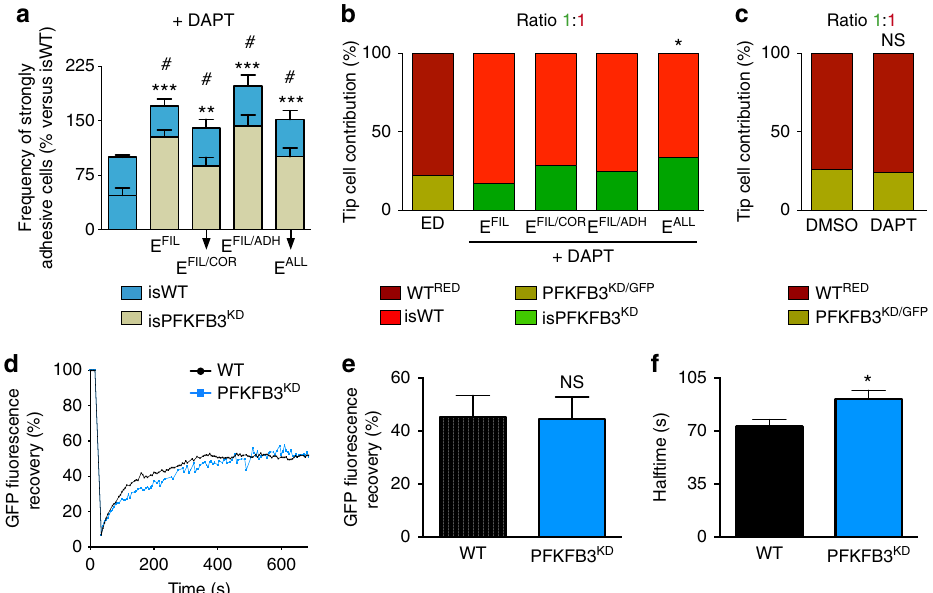
Figure 4 | PFKFB3 KD increases intercellular heterogeneity. ( a ) Analysis of EC adhesive strength of isWT cells in isWT:isWT sprouts (first bar) and isPFKFB3 KD-FIL , isPFKFB3 KD-FIL/COR , isPFKFB3 KD-FIL/ADH and isPFKFB3 KD-ALL cells in a 1:1 isPFKFB3 KD :isWT mosaic sprout treated with DAPT. Modifying E FIL , E FIL/COR , E FIL/ADH and E ALL increased the fraction of isPFKFB3 KD cells that were classified as strongly adhesive, less motile cells (resulting in more heterogeneity in adhesion between sprout cells). Data are mean ± s.e.m.; n ¼ 10; ** P o 0.01 and *** P o 0.001 versus isWT for total number of